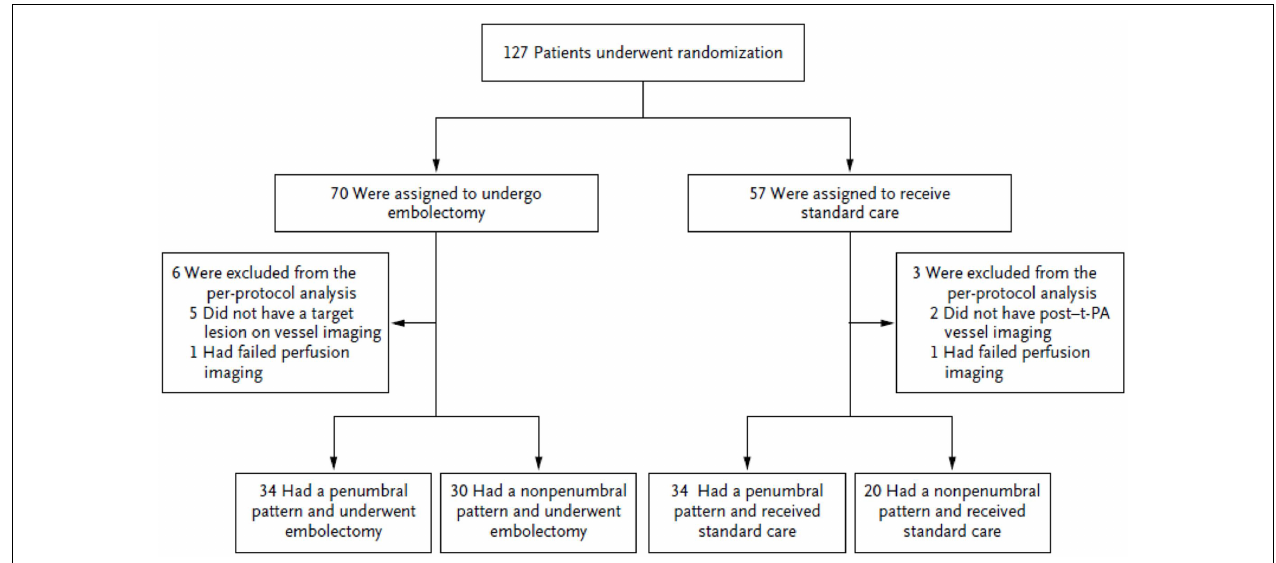
FIGURE 2 | Study design of MR-RESCUE .